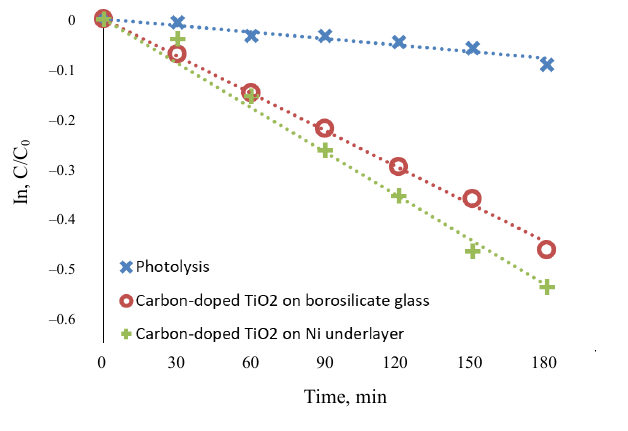
Fig. 5. RhB solution bleaching by the visible light activated carbon-doped TiO 2